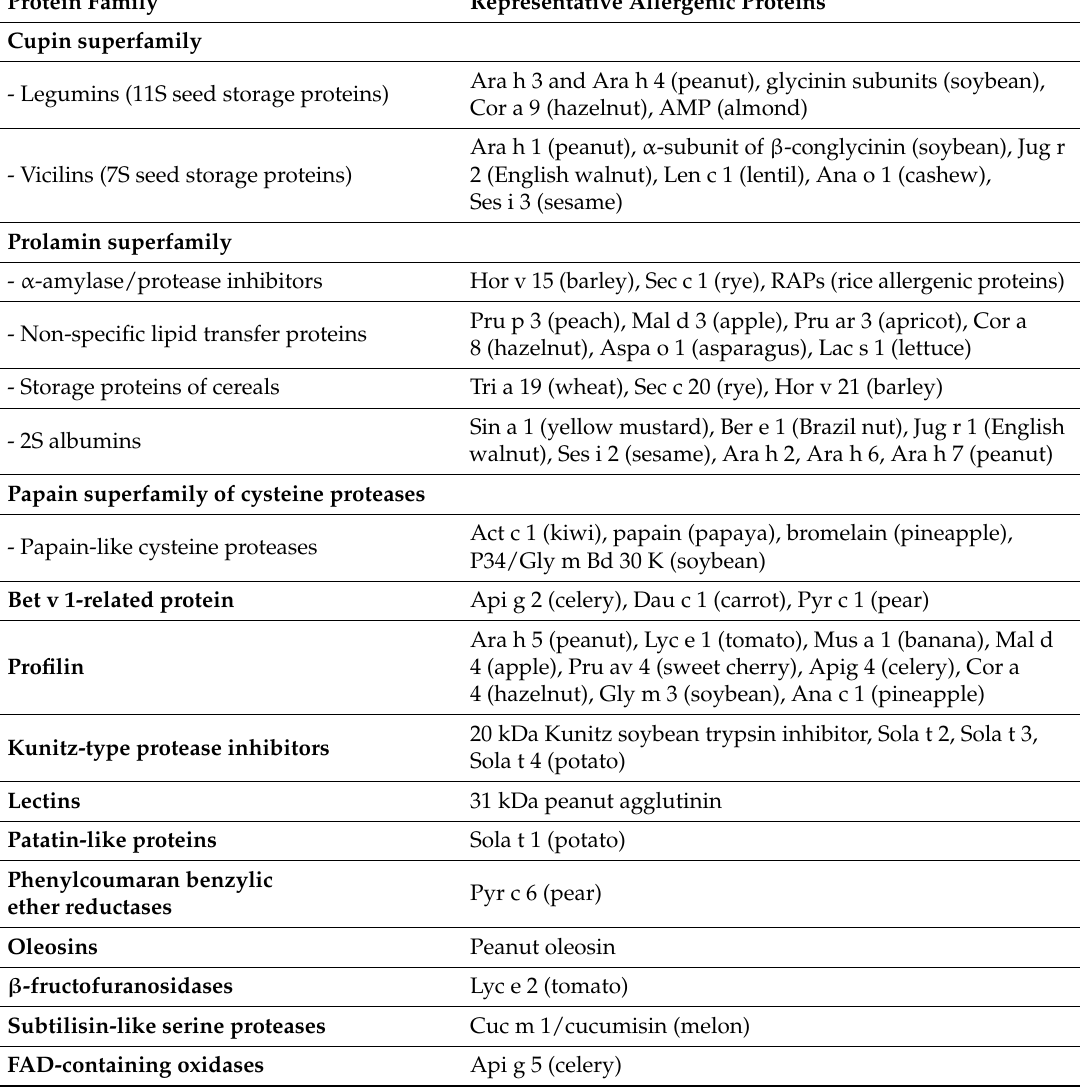
Table 2. Major food allergens from plant sources